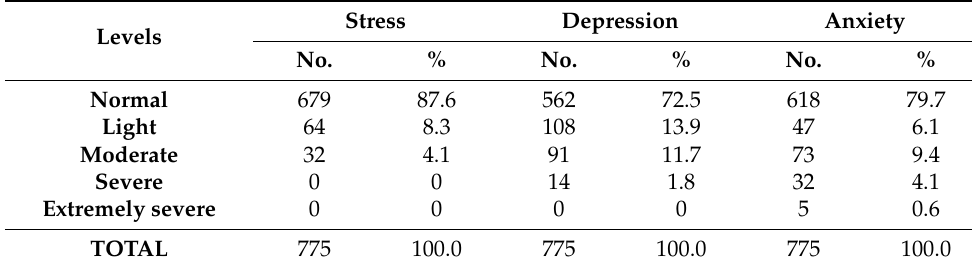
Table 1. Severity of students’ affective–emotional states. Stress Levels